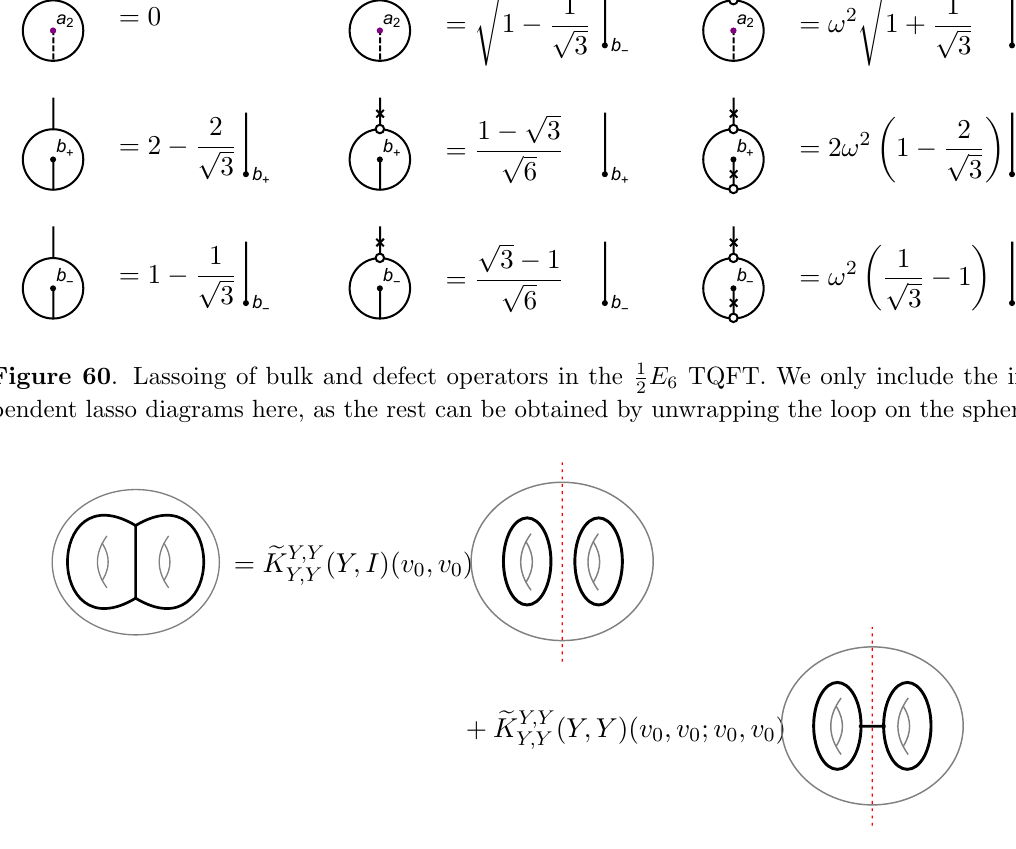
Figure 61 . Crossing transformation on the genus-two partition function with two Y loops. The Y Y Y junction only involves the junction vector v 0 , as the contributions involving the junction vector v 1 vanish, due to the vanishing results of the torus one-point functions in (cid:12)gure 58. Likewise, there is no contribution from a pair of Y loops connected by an X